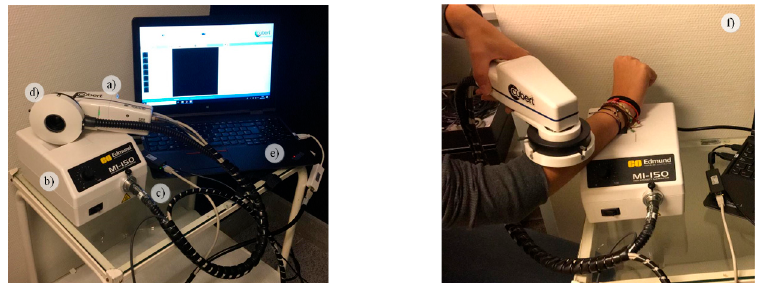
Figure 1. HS dermatologic acquisition system. ( a ) HS snapshot camera; ( b ) QTH (Quartz-Tungsten Halogen) source light; ( c ) Fiber optic ring light guide; ( d ) 3D printed customized dermoscopic contact